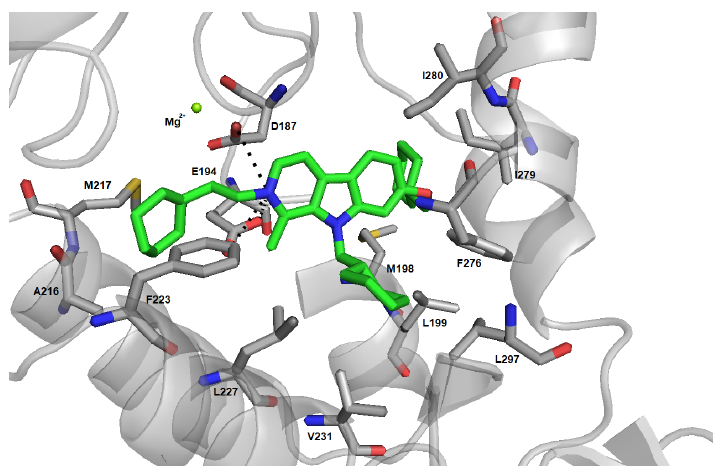
Figure 4. Structure of docked inhibitor 124 (green) within the active site of